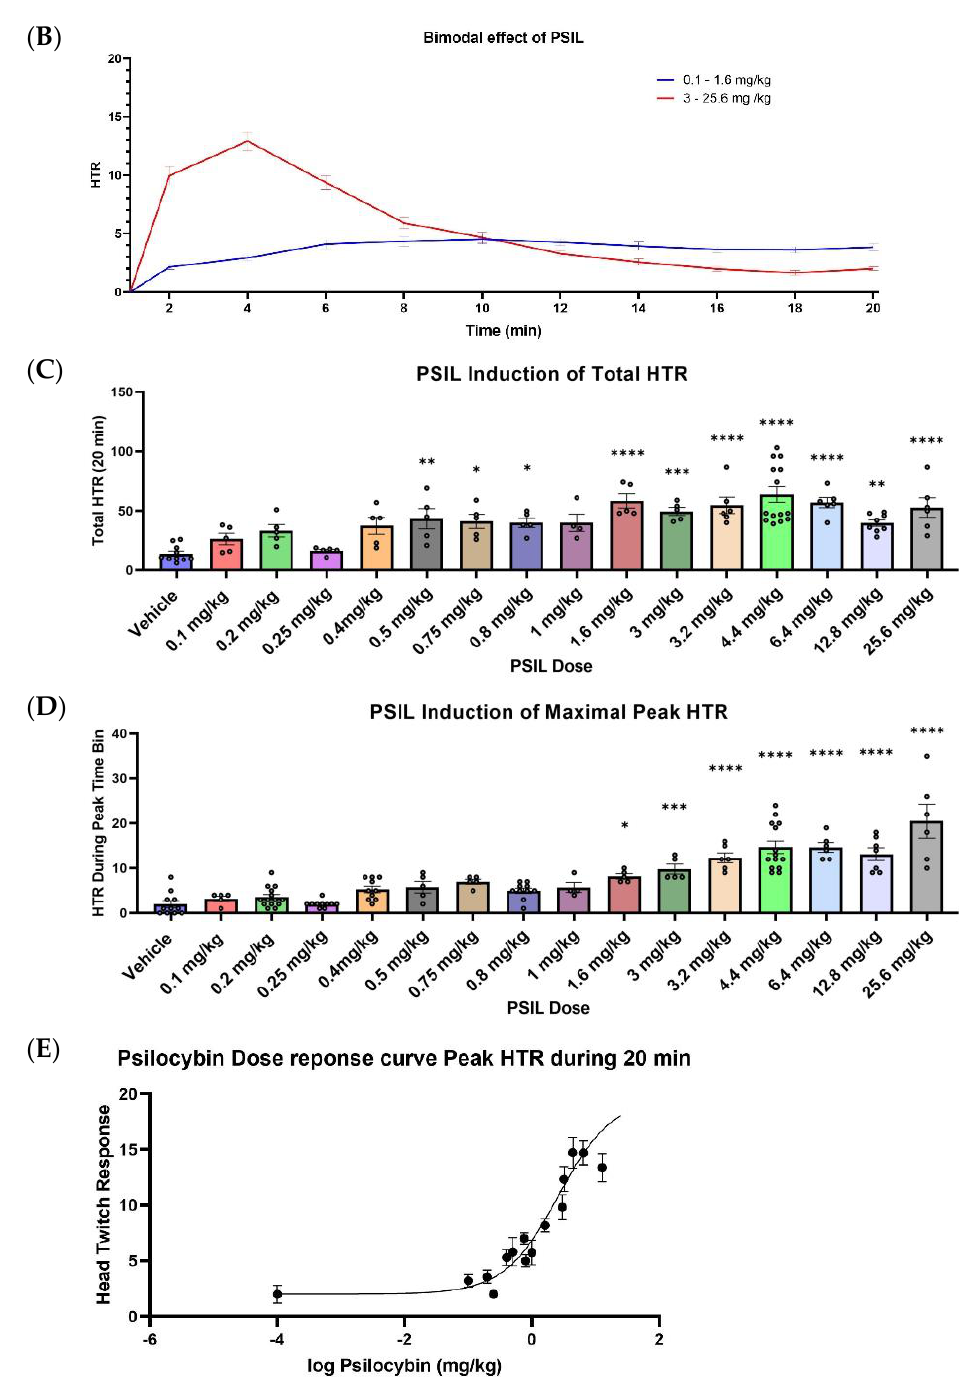
Figure 3. PSIL induced HTR, over time ( A ), bimodal effect ( B ), total HTR during 20 min ( C ) and maximal peak HTR in a 2 min bin over 20 min ( D ) ( n = 5–14). ( A ) Effect of different PSIL concentrations during HTR over the time course of 20 min post-injection. (B) Bimodal HTR effect of high and low doses over the time course of 20 min post-injection. ( C ) Total HTR during the 20 min post injection. ( D ) Maximal peak HTR that was produced in a 2 min time bin over the course of 20 min ( E ) Logarithmic dose-response curve compiled from peak HTR ( D ). Compared to vehicle, * p < 0.05, ** p < 0.01, *** p < 0.001, **** p < 0.0001. Error bars represent SEM.